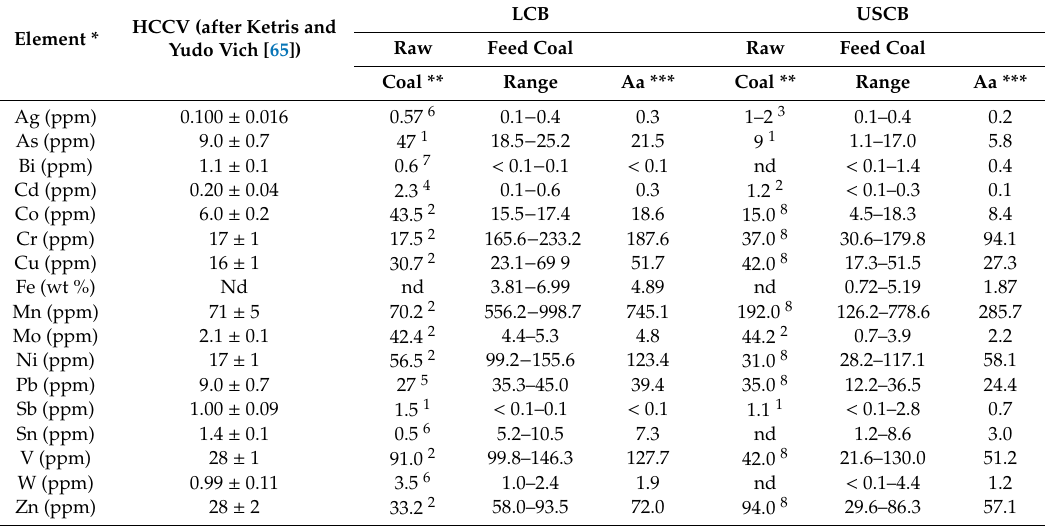
Table 2. Average contents of elements in raw coal and in feed coals from the LCB and USCB compared to hard-coal Clarke values